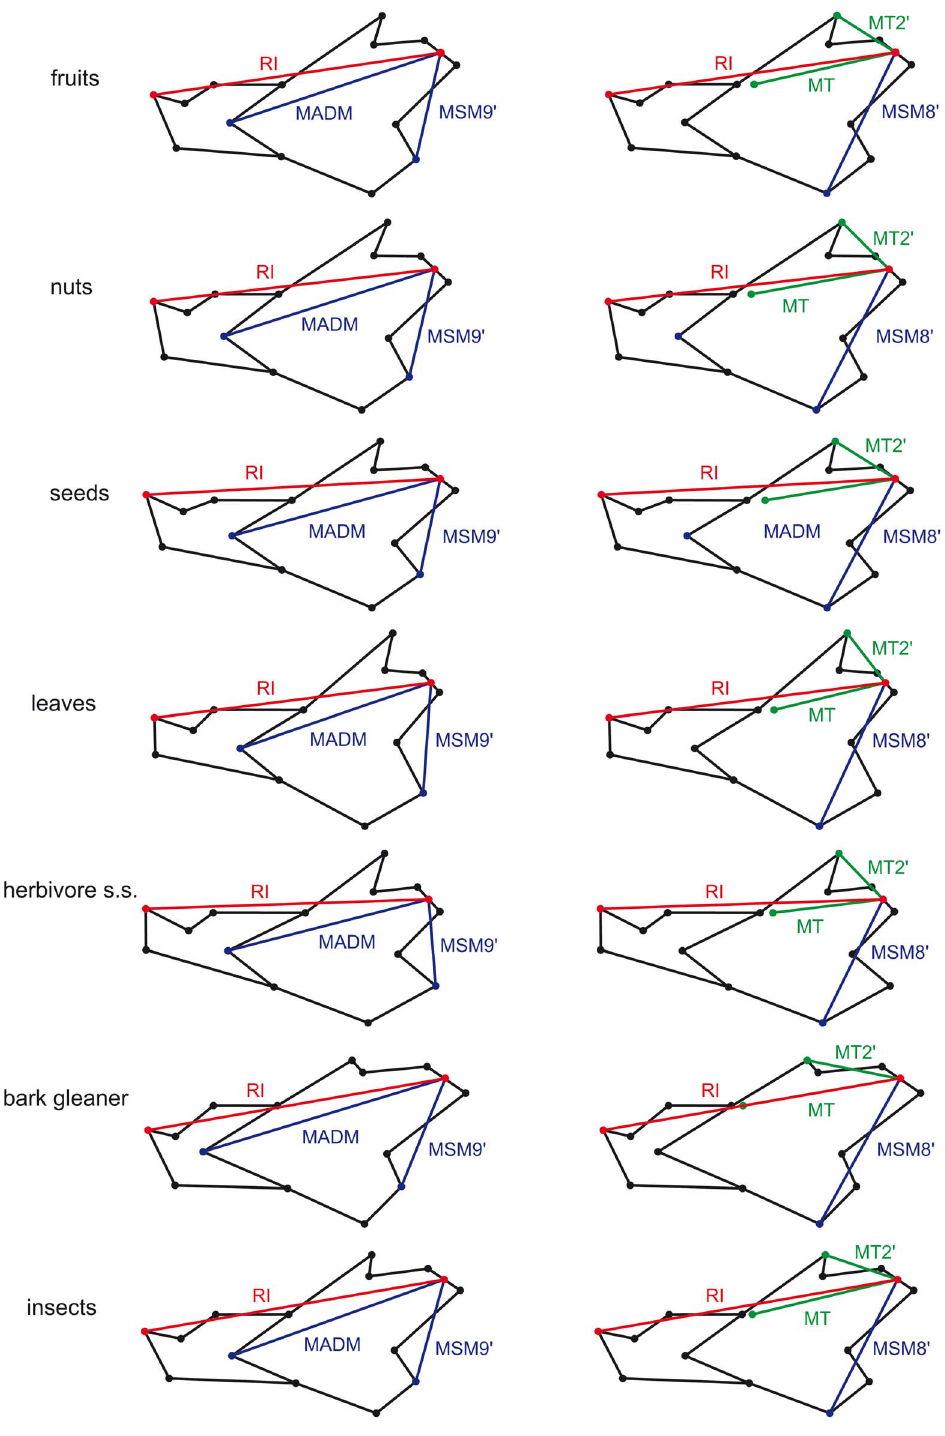
Figure 5. Muscle moment arms and resistance arm for the incisor for the mean shape of the main dietary groups. The numerical values for the mean of each group are given in Table 2. Values for each squirrel species are given in Table 1. See Figure 1 for the meaning of the acronyms.